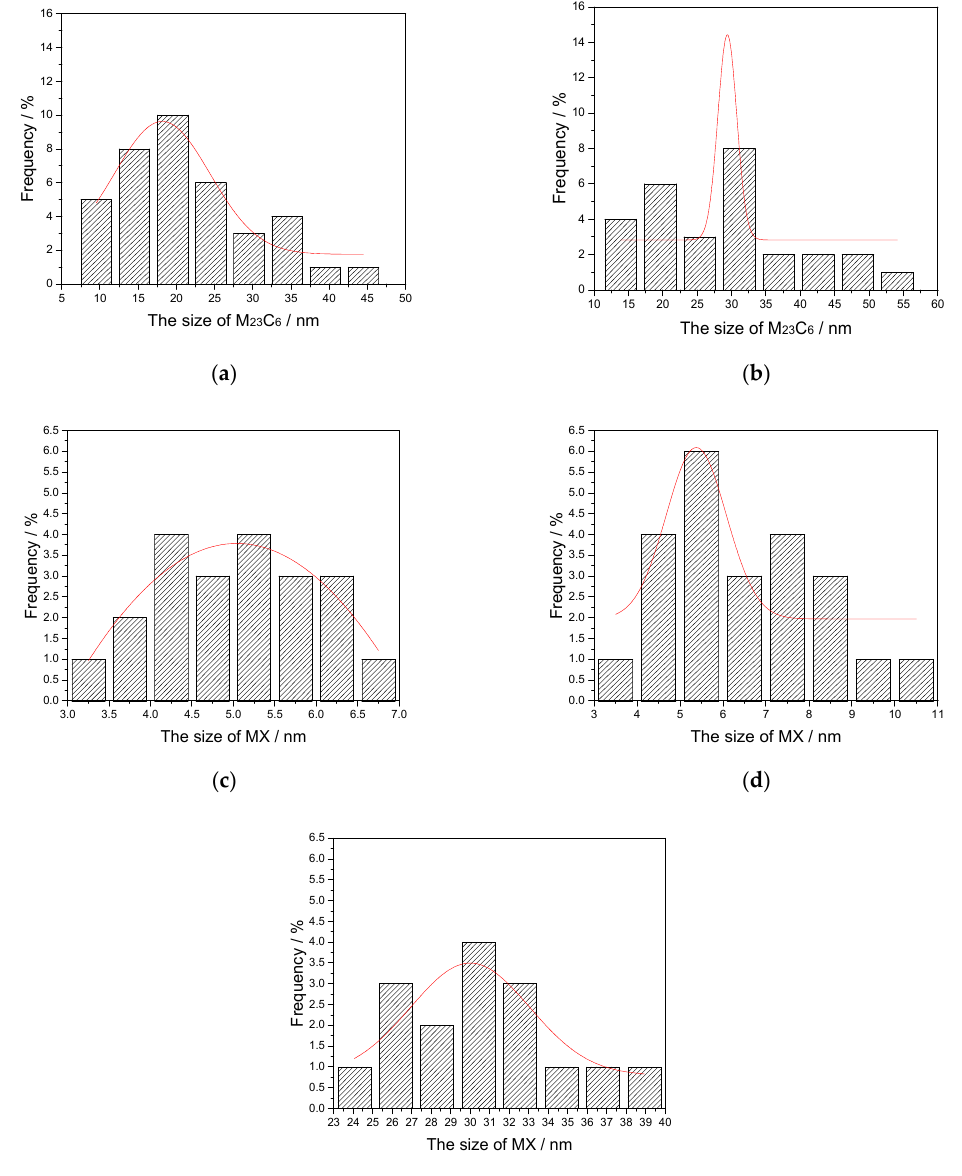
Figure 5. ( a , b ) The normal distribution of M 23 C 6 precipitates size, holding at 900 and 1000 °C for 400 s; ( c – e ) The normal distribution of MX precipitates size, holding at 900, 1000, and 1100 °C for 400 s. The red curve represents the normal distribution curve of carbide size.